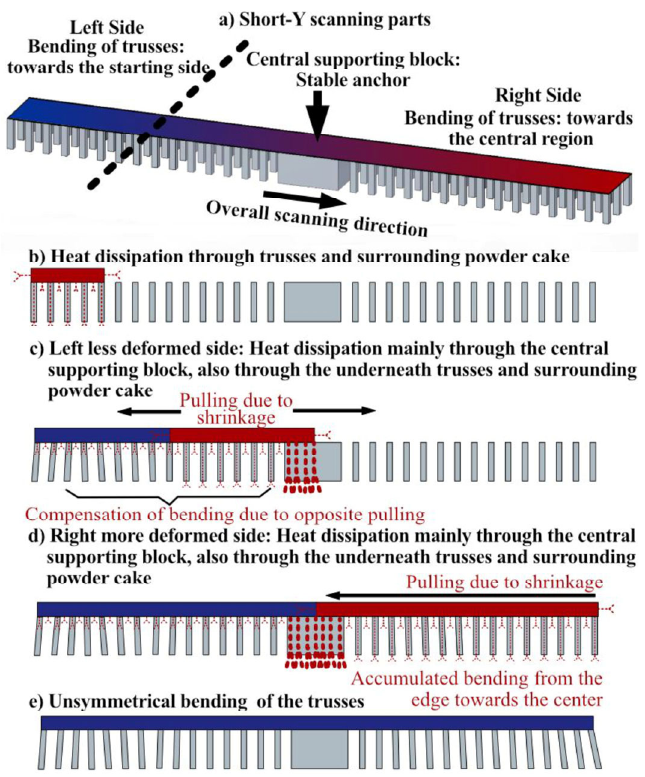
Figure 23. Schematic postulation for unsymmetrical bending of the trusses, supporting panels with short ‐ Y scans.